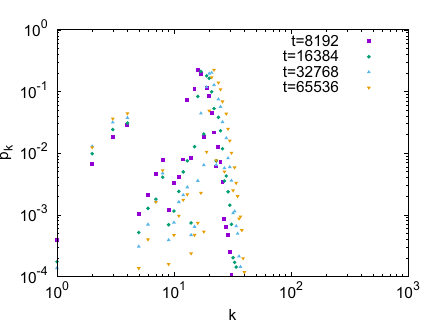
Figure 1. ( a ) A network consisting of five nodes v , w , x , y and z . ( b ) A Galois connection ( F , G ) associated with the network shown in ( a ). Here, we assume that δ x X . Equivalent elements in each preordered set are enclosed in the same round box. Even if we change the ′ ∈ value of F (3) from y to x or z , ( F , G ) is still a Galois connection since x , y and z are equivalent.